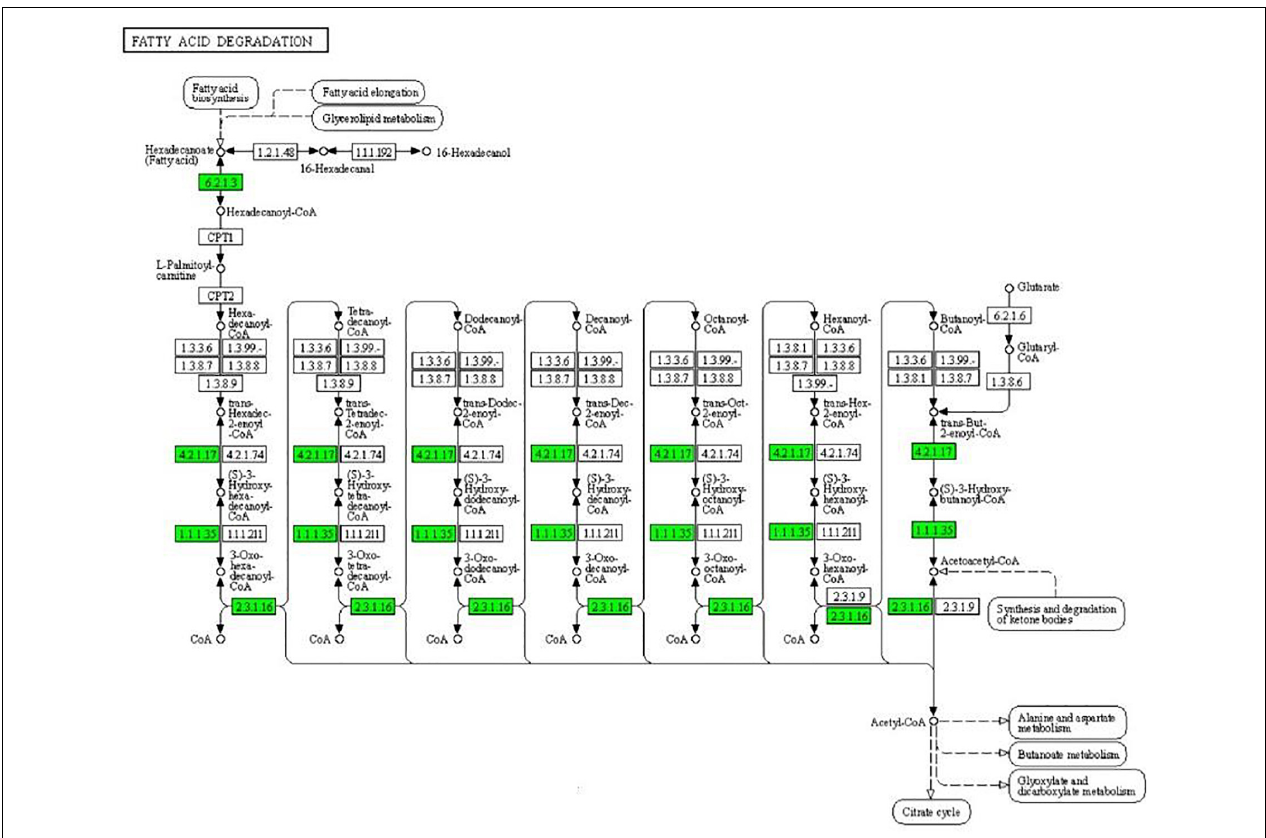
FIGURE 4 | Significantly enriched KEGG pathway: Fatty acid degradation (from the KEGG database, green frames represent downregulation, and red frames represent